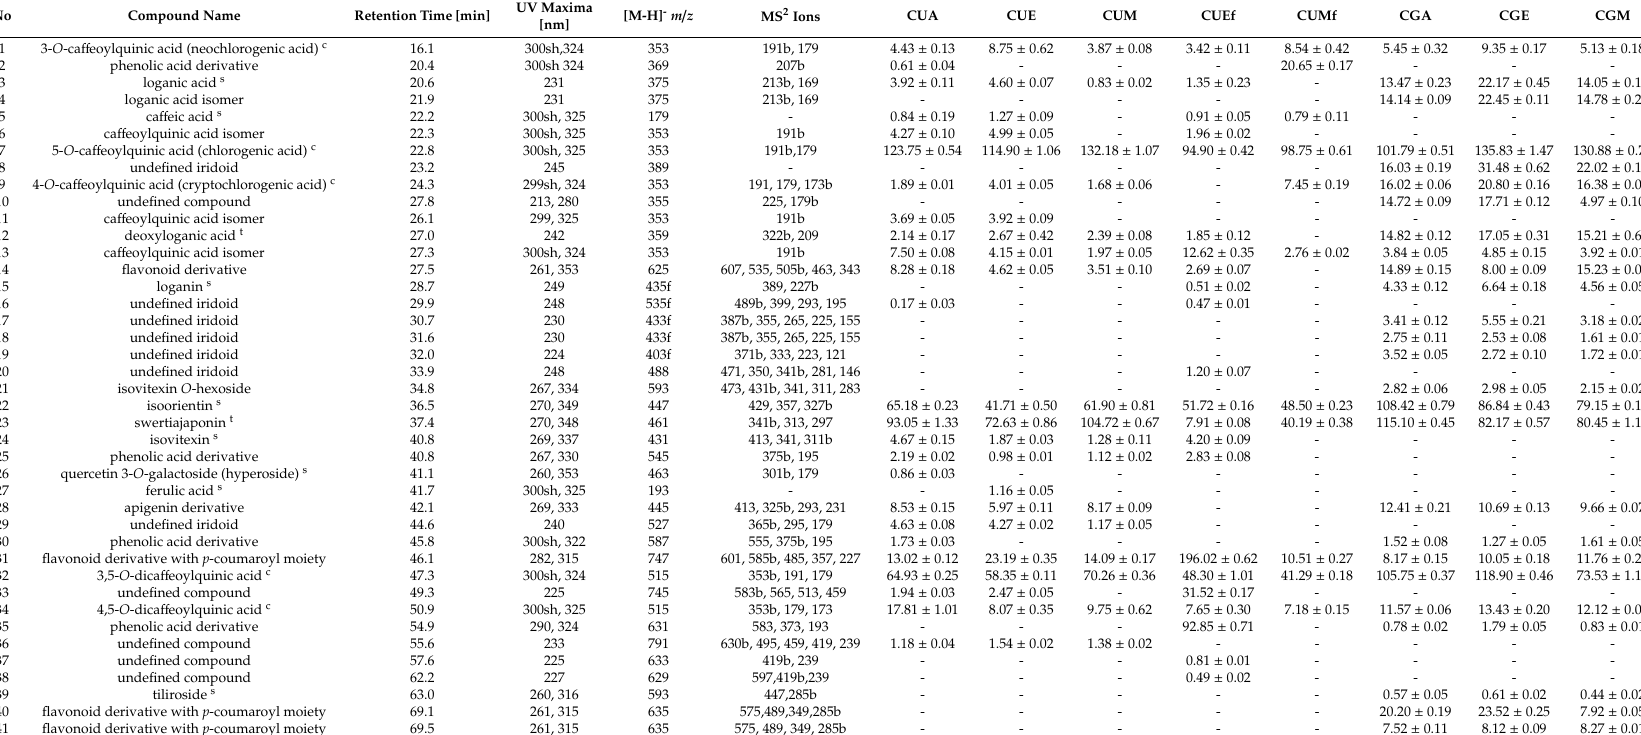
Table 1. LC-DAD-MS / MS data for compounds detected in the C. uralensis and C. gigantea extracts. CUA—acetone extract of the aerial parts of C. uralensis , CUE—ethanol extract of the aerial parts of C. uralensis , CUM—methanol–acetone–water extract of the aerial parts of C. uralensis , CUEf—ethanol extract of the flowers of C. uralensis , CUMf—methanol-acetone-water extract of the flowers of C. uralensis , CGA—acetone extract of the aerial parts of C. gigantea , CGE—ethanol extract of the aerial